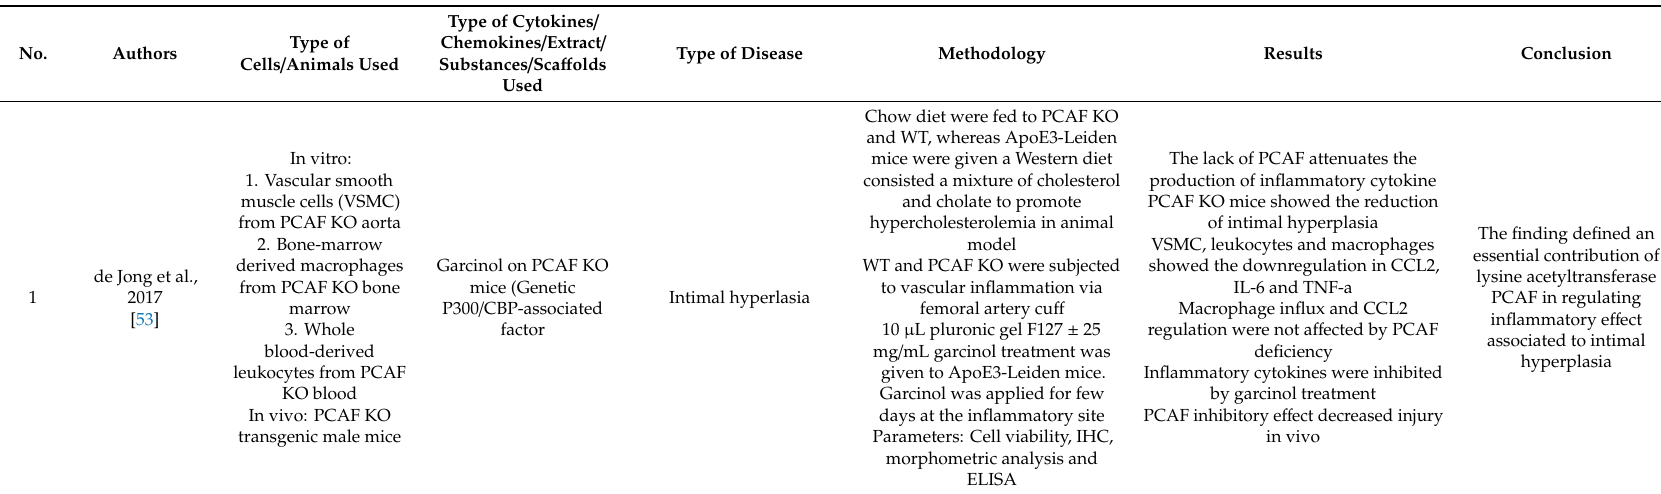
Table 2. Summary of the 8 articles conducted in vitro and in vivo that were selected from both Pubmed and Scopus